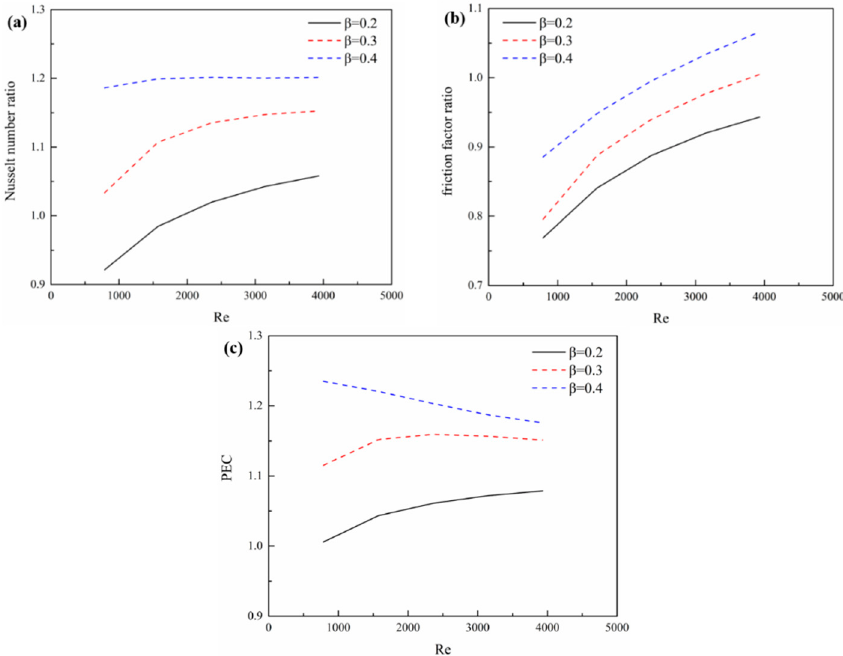
Figure 7. Influence of different staggered ratio on heat transfer performance with Reynolds number.